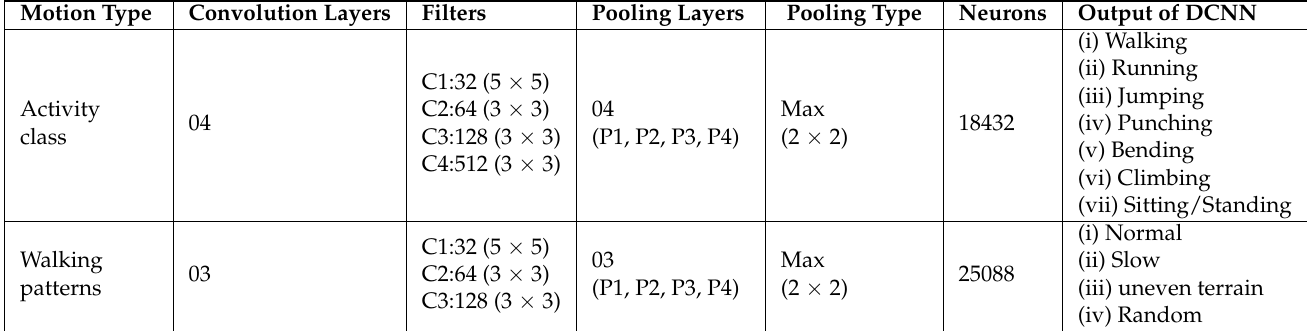
Table 2. DCNN architecture and parameter